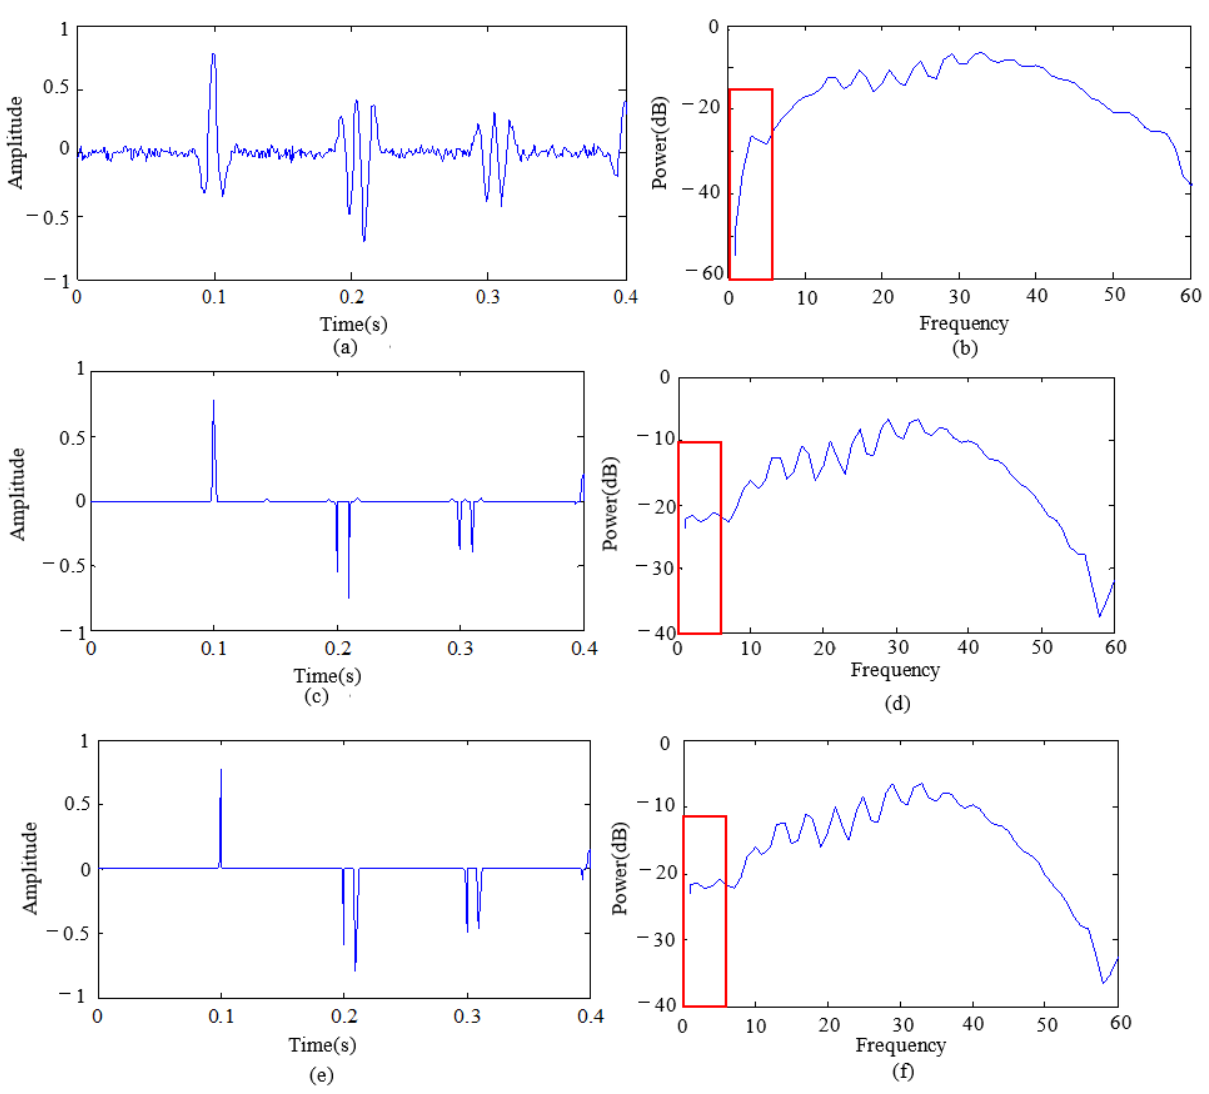
Figure 6. Comparisons of low frequency expansion when SNR = 14.72. ( a , b ) Noisy data and their frequency spectrum, ( c , d ) reflection coefficients estimated by CS and extended spectrum, ( e , f ) reflection coefficients estimated by proposed method and extended spectrum.